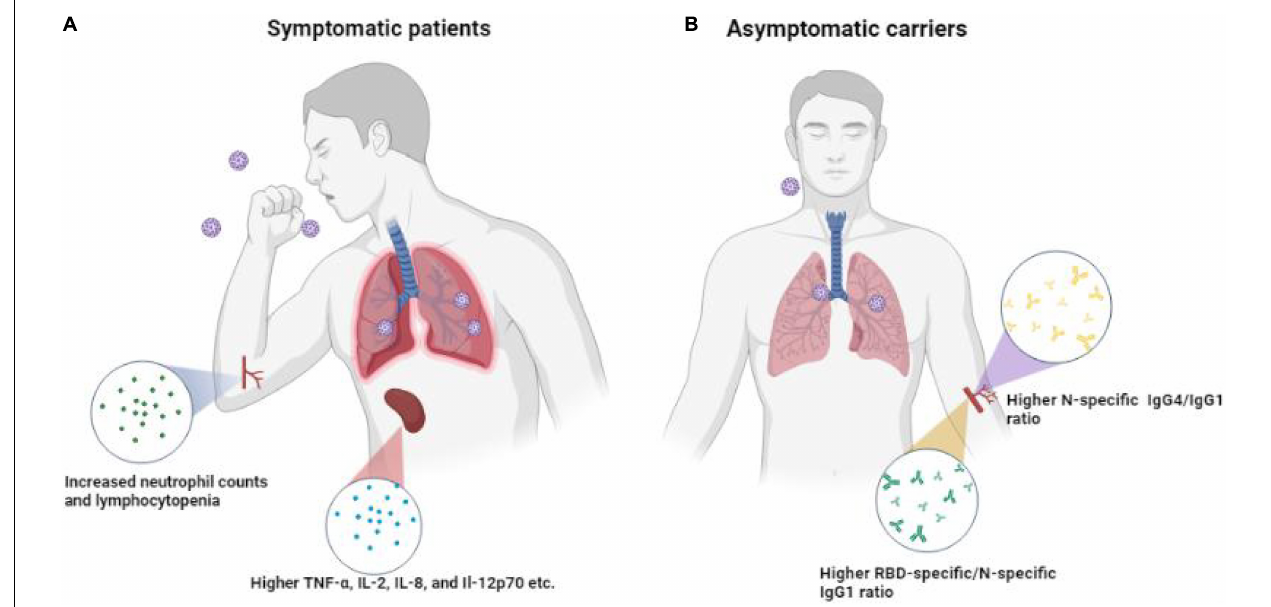
FIGURE 8 | Differences in immune response in SPs, ACs, and HCs. (A) Symptomatic patients exhibited higher anti-RBD/anti-N antibody ratios and higher TNF- α , IL-2, IL-8, and IL-12p70. (B) Asymptomatic carriers exhibited higher N-specific IgG4/IgG1 ratio